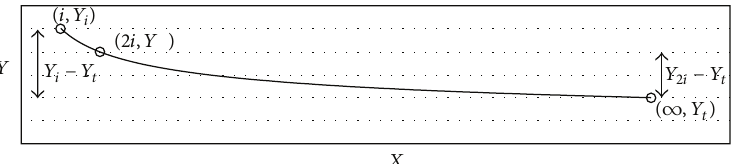
Figure 1: The power curve model of 𝑌 as a function of 𝑋